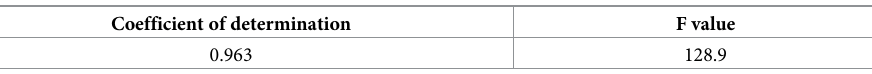
Table 7. Coefficient of determination and F